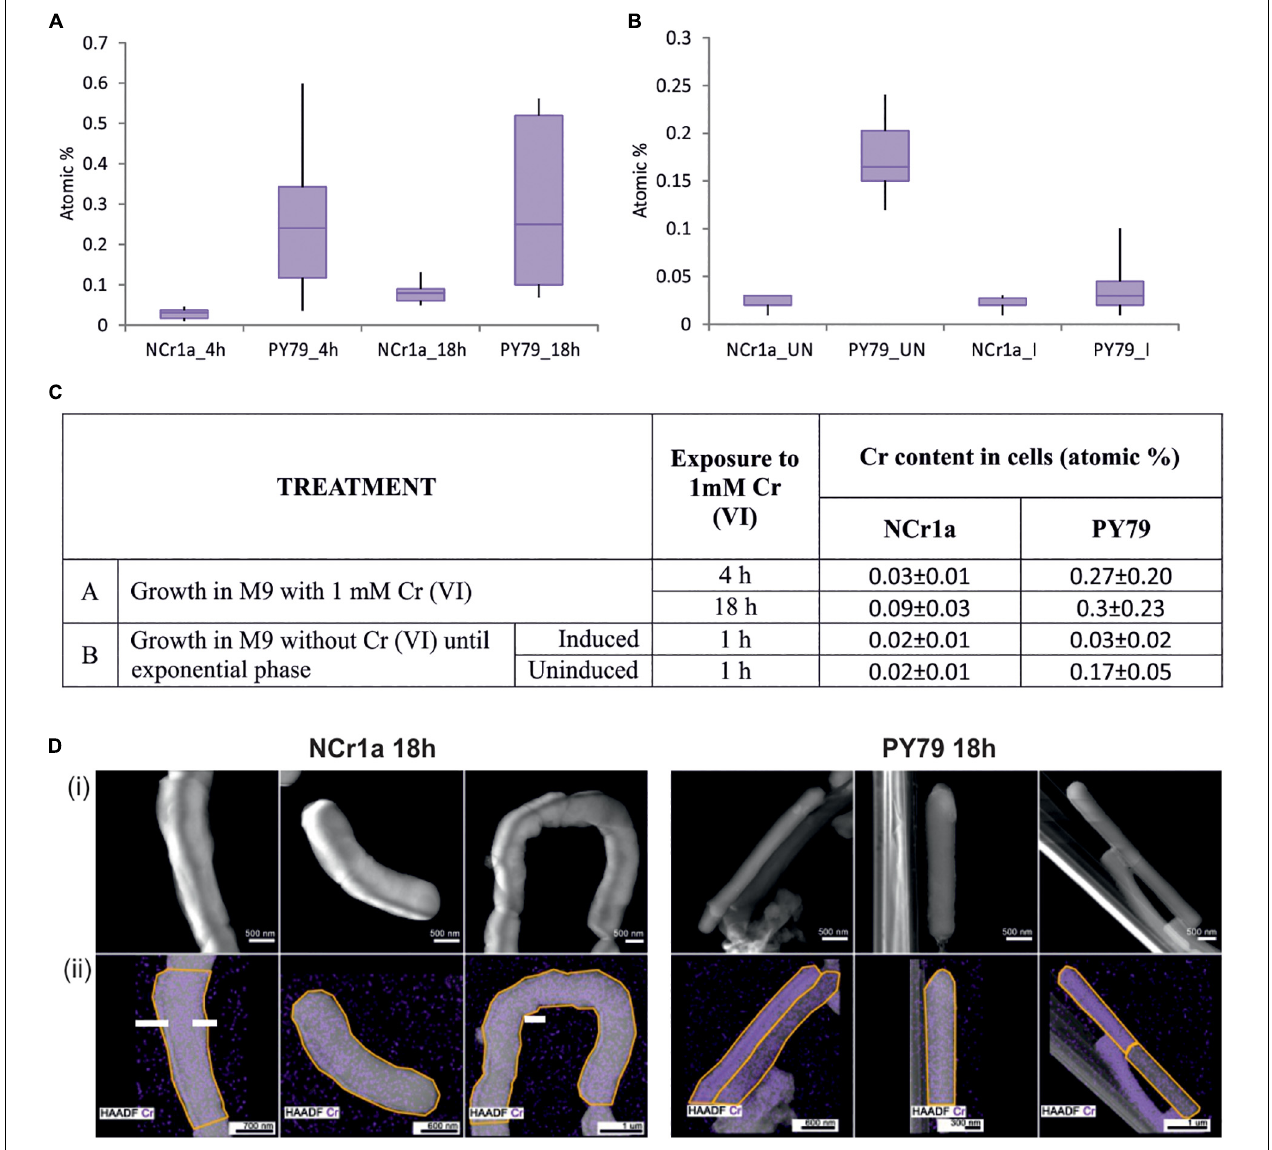
FIGURE 1 | Accumulation of Cr by cells after growth with 1 mM Cr(VI). (A,B) Box plot diagrams describe the range and distribution of Cr content between cell categories, using quartiles. At least 10 different cells were analyzed for each group. (A) The accumulation of Cr by cells of Cr-tolerant NCr1a strain and Cr-sensitive PY79 strain after 4, respectively, 18 h of growth. (B) The accumulation of Cr by cells of Cr-tolerant NCr1a strain and Cr-sensitive PY79 strain after exposure to 1 mM Cr for 1 h with or without prior induction with a sub-inhibitory concentration of Cr(VI). “I” indicates induced sample, “UN” indicates uninduced sample. (C) Summary of treatment and respective average Cr content values for strains NCr1a and PY79. (D) Accumulation of Cr by NCr1a and PY79 cells after 18 h growth with 1 mM Cr(VI) as observed by STEM-EDS. Cr is mapped in violet color (i) High angle annular dark-field images (HAADF) of bacteria exposed to Cr together with (ii) Cr elemental distribution maps acquired by EDS, areas where the spectra were taken are marked by the yellow